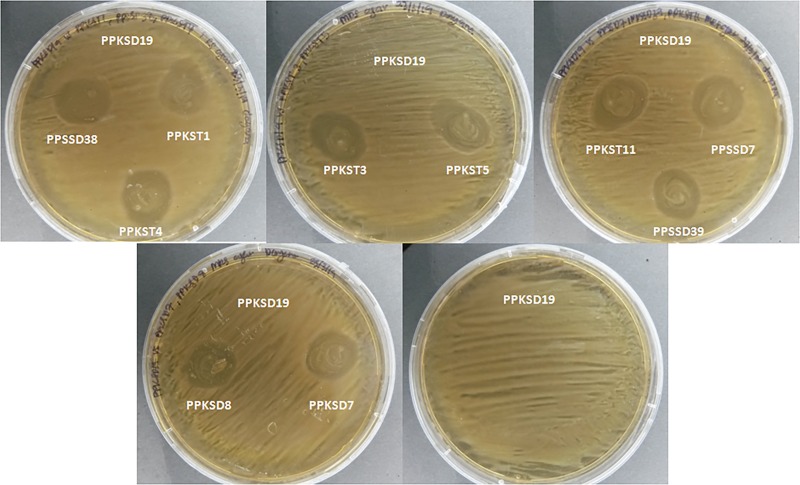
In vitro compatibility test between W. cibaria PPKSD19 and ten different isolates of L. lactis subsp. lactis.All L. lactis subsp. lactis isolates (PPSSD7, PPSSD38, PPSSD39, PPKSD7, PPKSD8, PPKST1, PPKST3, PPKST4, PKST5 and PPKST11) were streaked circularly while the W. cibaria PPKSD19 isolate was spread on the MRS agar plate.